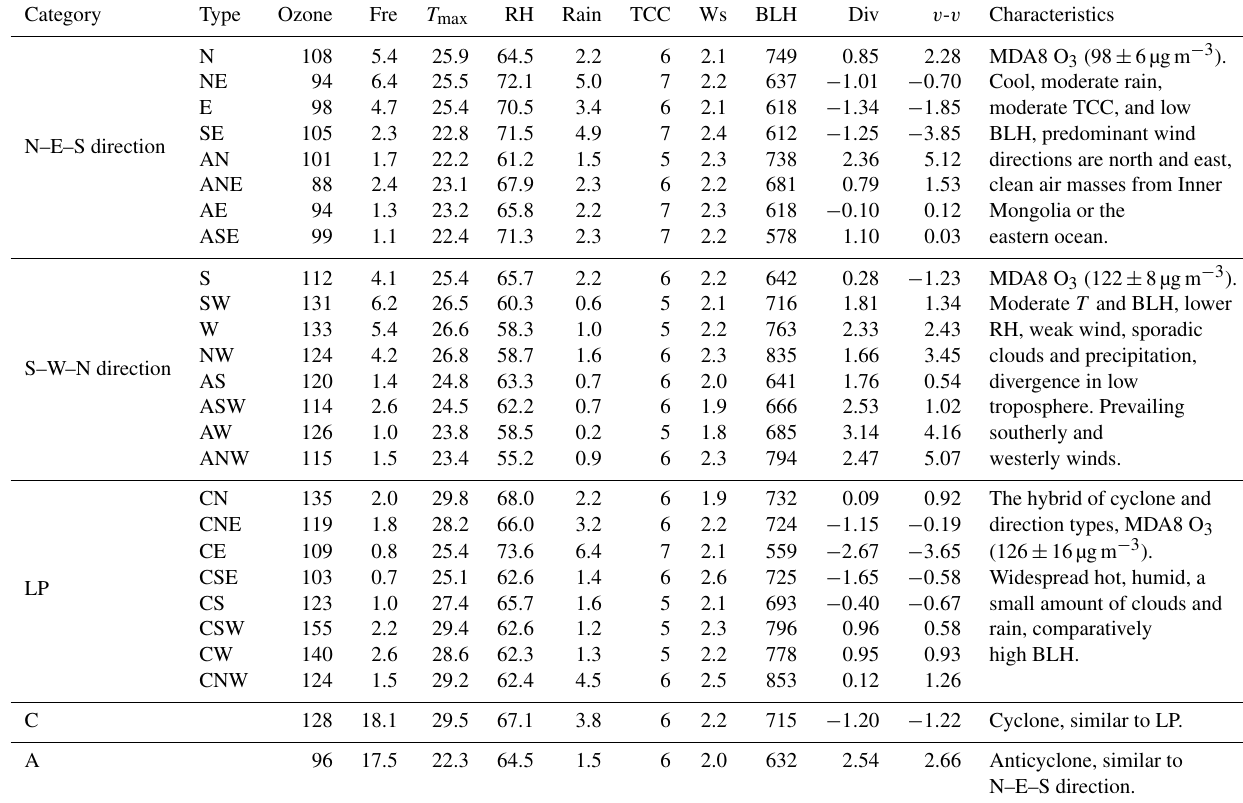
Table 1. Weather types, ozone concentrations and meteorological conditions for five weather